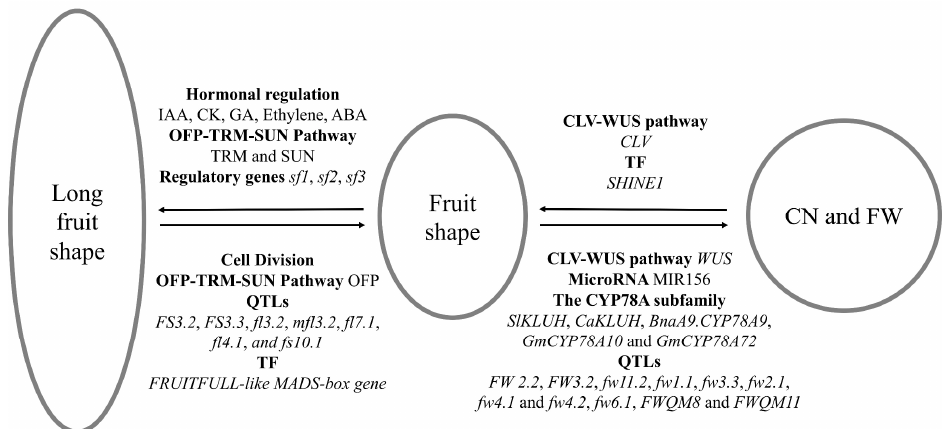
Figure 2. Fruit shape is regulated by several other signaling pathways. These regulation pathways include hormonal regulations, OFP-TRM-SUN pathway, regulatory genes, cell division, QTLs, and TF, which affect the fruit length. The TF, CLV-WUS signaling pathway, MicroRNA, the CYP78A subfamily, and QTLs affect the CN and the FW. These pathways are shown around in